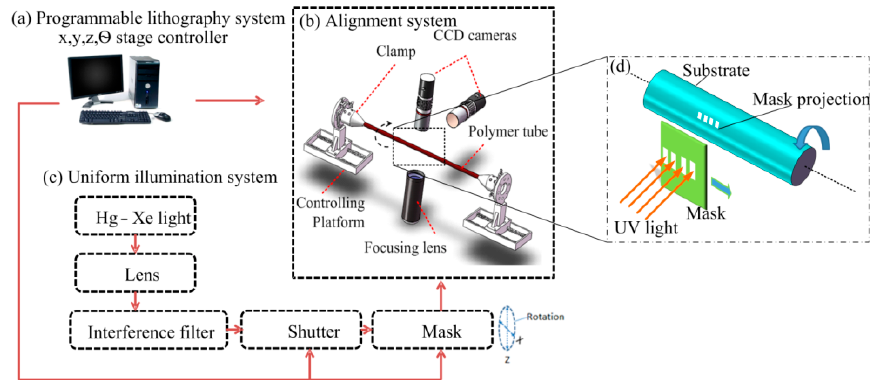
Figure 6. Programmable UV lithography system with alignment for cylindrical substrate: ( a ) programmable lithography system x, y, z, θ -stage controller; ( b ) Charge Coupled Device (CCD) camera alignment system; ( c ) Uniform illumination system; ( d ) Close-up schematic diagram of fabricated sample.